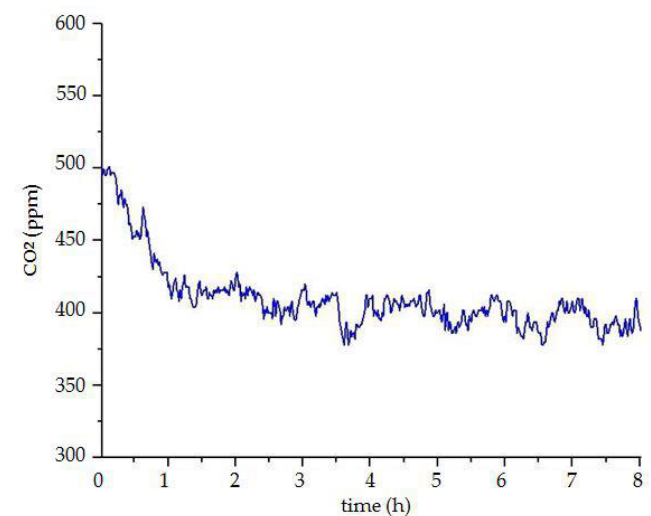
Figure 21. The curve of carbon dioxide concentration.